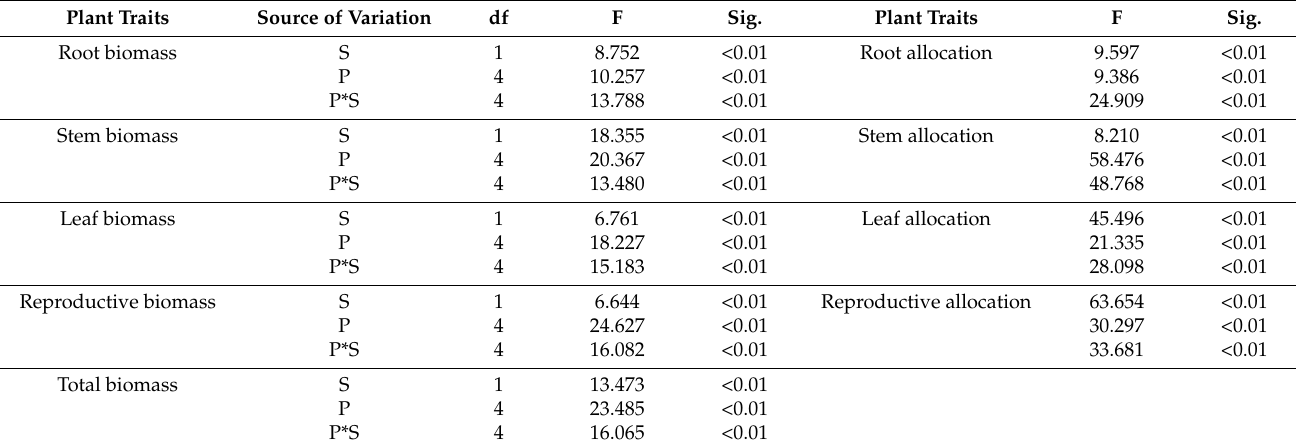
Table 2. Summary of a two-way ANOVA showing the effects of different emergence seasons and extreme precipitation on biomass accumulation and allocation of Erodium oxyrhynchum . P, extreme precipitation; S, emergence season; P*S, extreme precipitation × emergence season.